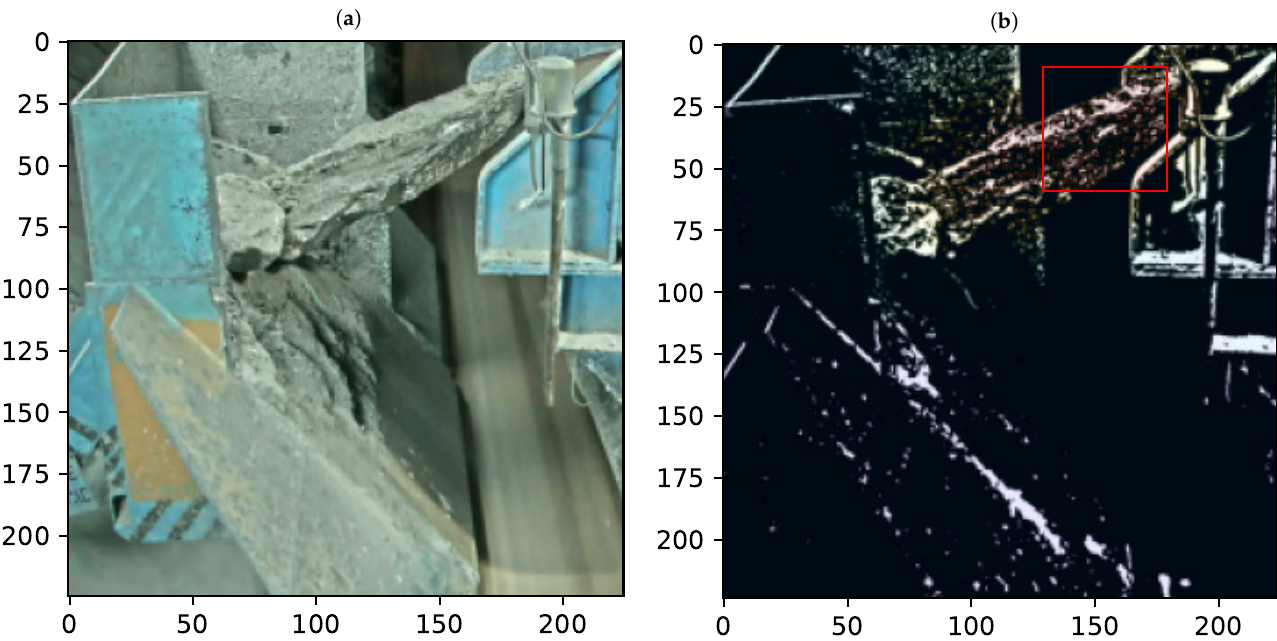
Figure 13. The result of the autoencoder network operation: ( a ) original image of blockage—oversized rock; ( b ) location of the anomaly most